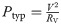
(a) Electrical circuit representing the physical layer of the system. The circuit is composed by a power source V and RV, and resistors of R in parallel, generating a current I. These resistors are related to N agents that can add, remove or keep the resistors under their control in the circuit. The minimum number of resistors an agent can have is one and there is no maximum. We also consider N as the size of the system. (b) The agents are connected in a communication network so that a given agent has access to the information related to the previous action of their first-order neighbours. In the ring topology illustrated here, every agent is connected with two other agents. In this case agent i is connected with agents i − 1 and i+1 with i = 1, 2, …, N. In the ring topology, agents 1 and N are neighbours. (c) At time step t, the normalized power delivered Pall[t]/Ptyp to the agents with rising number of resistors n[t] in the system, where Ptyp=V2RV and Pall[t]=∑i∈APi[t] with Pi[t] given by Eq (1).